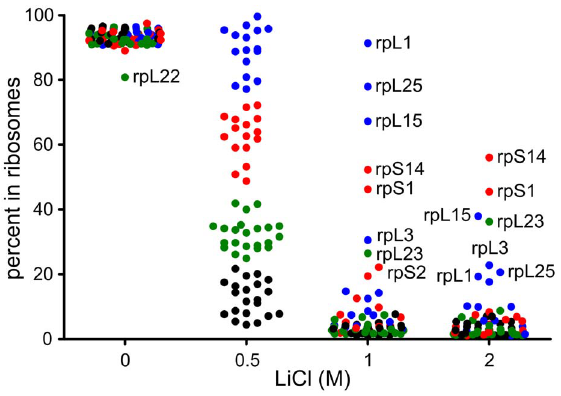
Figure 2. Splitting of ribosomal proteins from yeast ribosomes by LiCl. ‘‘Light’’ yeast 80S ribosomes were incubated with 0 M, 0.5 M, 1 M or 2 M LiCl, whereafter core and supernatant fractions were separated by centrifugation and ‘‘heavy’’ ribosomes were added to each fraction. Ribosomal proteins were precipitated with TCA, hydrolysed with Lys-C or with Lys-C + trypsin and peptides were separated by HPLC. ‘‘Heavy’’ to ‘‘light’’ ratio of peptides was determined by MS/MS for each protein. Proteins are grouped according to their amount in the core fraction at 0.5 M LiCl. Group A (blue) – 75–100%, B (red) – 48–75%, C (green) – 22–48% and D (black) – 0–22% in the core. tion. The ribosomal core and supernatant fractions were separated by centrifugation. ‘‘Heavy’’ 80S ribosomes were added to each fraction followed by digestion of proteins by endoproteinases Lys- C alone or with combination with trypsin. ‘‘Heavy’’ to ‘‘light’’ ratio of peptides was determined by HPLC-MS/MS for each protein (except for rpL39, rpL40 and rpL41).